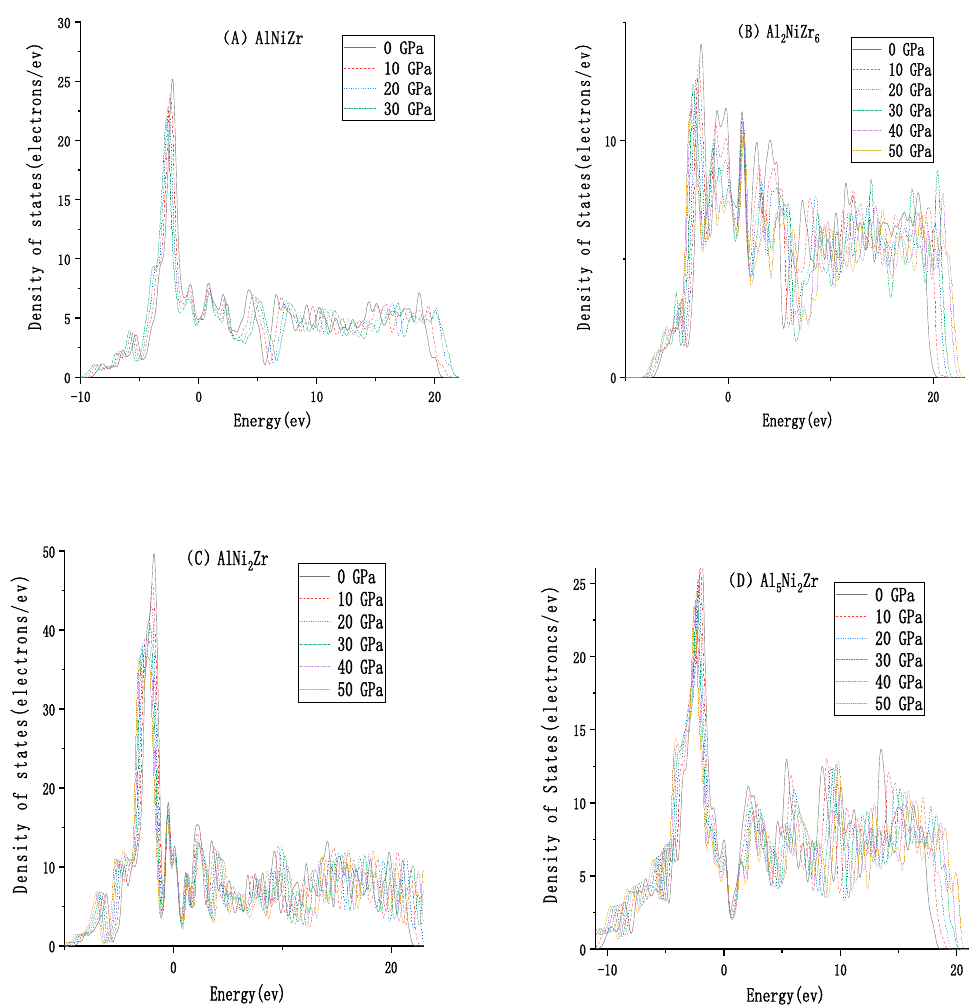
Figure 5. Total density of states versus pressure of ( A ) AlNiZr, ( B ) Al 2 NiZr 6 , ( C ) AlNi 2 Zr, ( D ) Al 5 Ni 2 Zr.